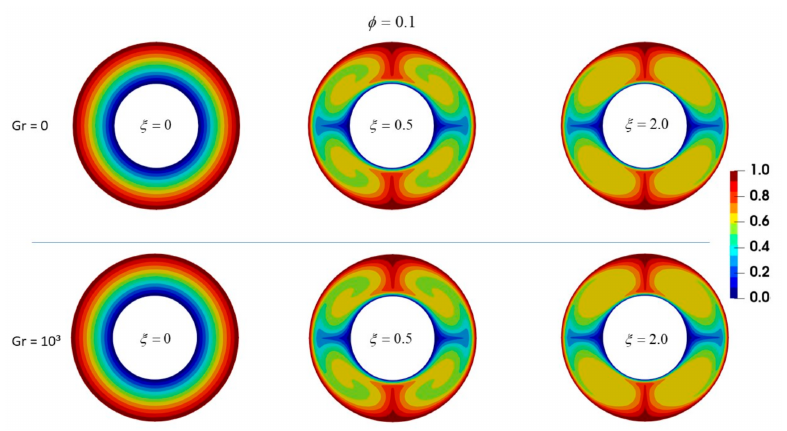
Figure 4. Contour plots of the temperature (cid:101) T for various values of ξ and Gr for φ = 0.1. Increasing the field strength ξ and concentration φ significantly improves the heat transfer at the walls, as expressed by the Nusselt number, due to the induction of the secondary flow. On the contrary, the increase in the Grashof number has a negligible effect on the heat transfer mechanism. As is presented in Figure 5, for φ = 0.01, the heat transfer increases around 168% on the inner wall and 145% on the outer wall, for field strength ξ = 2.0 in comparison to ξ = 0. This effect is much higher for φ = 0.1, where the heat transfer increases around 469% on the inner wall and 407% on the outer wall, for field strength ξ = 2.0 in comparison to ξ =